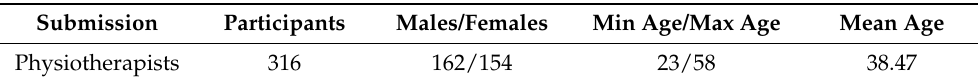
Figure 2. Diagram describing the inclusion process. Table 1. Characteristics of the participants.